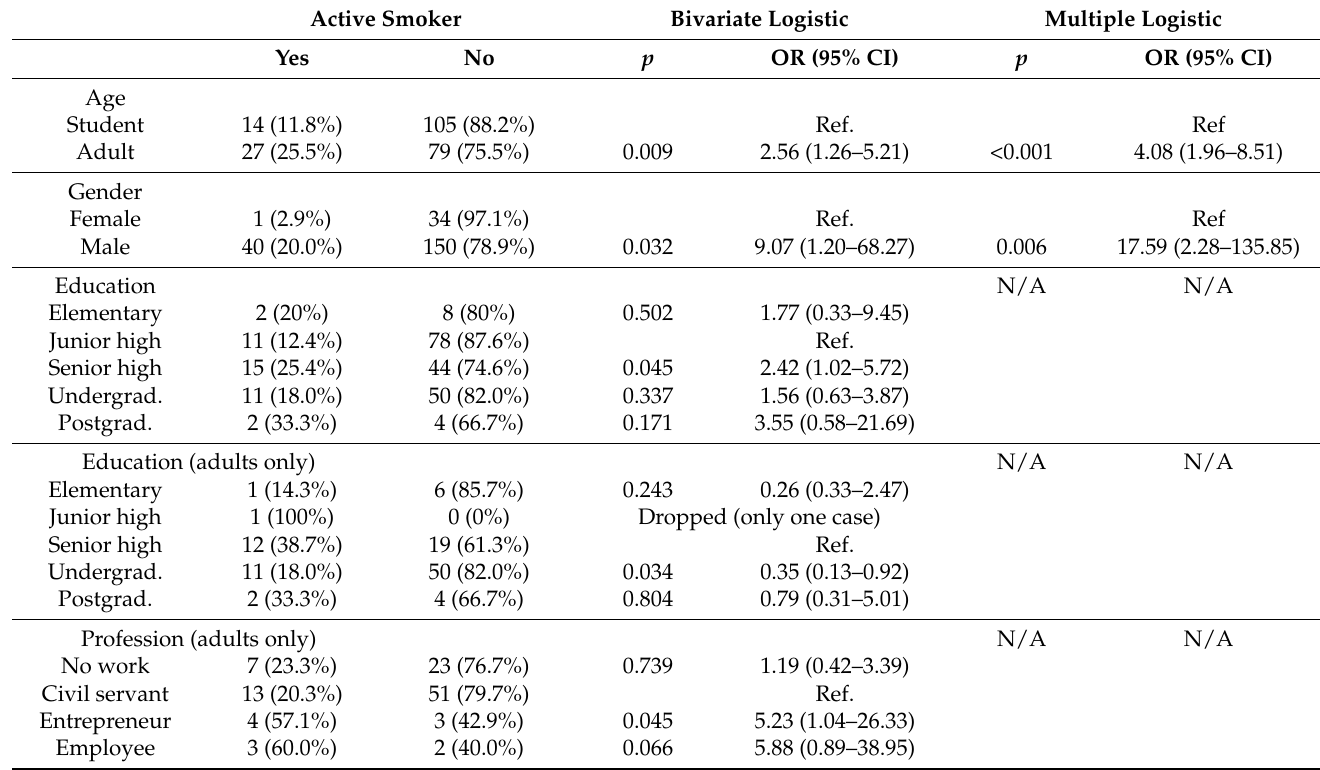
Table 2. Determinants of the active smoker